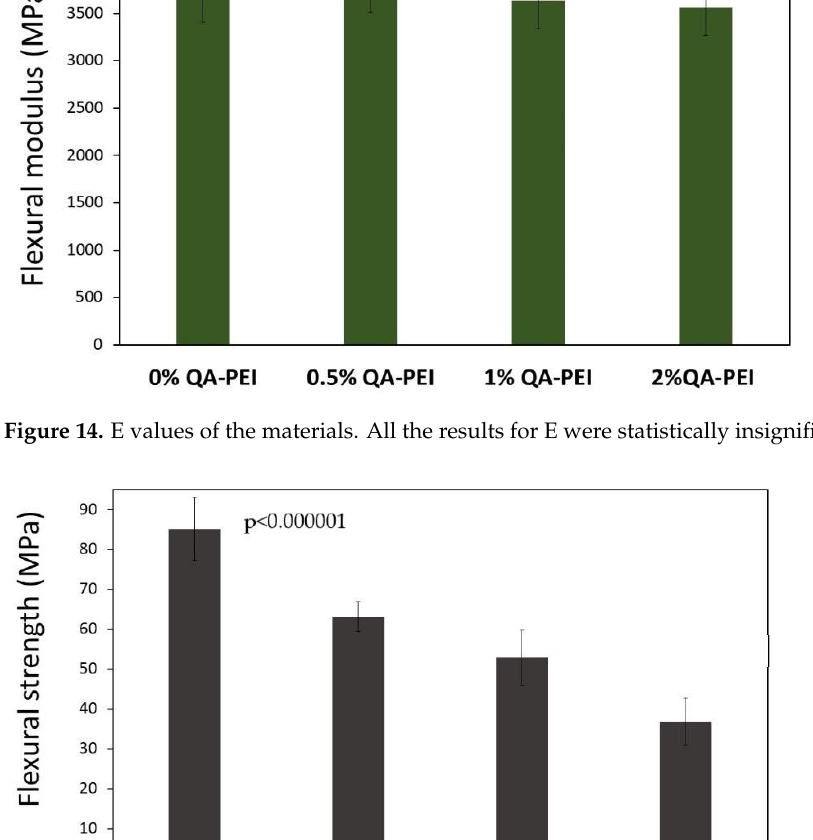
Figure 14. E values of the materials. All the results for E were statistically insignificant ( p > 0.05).